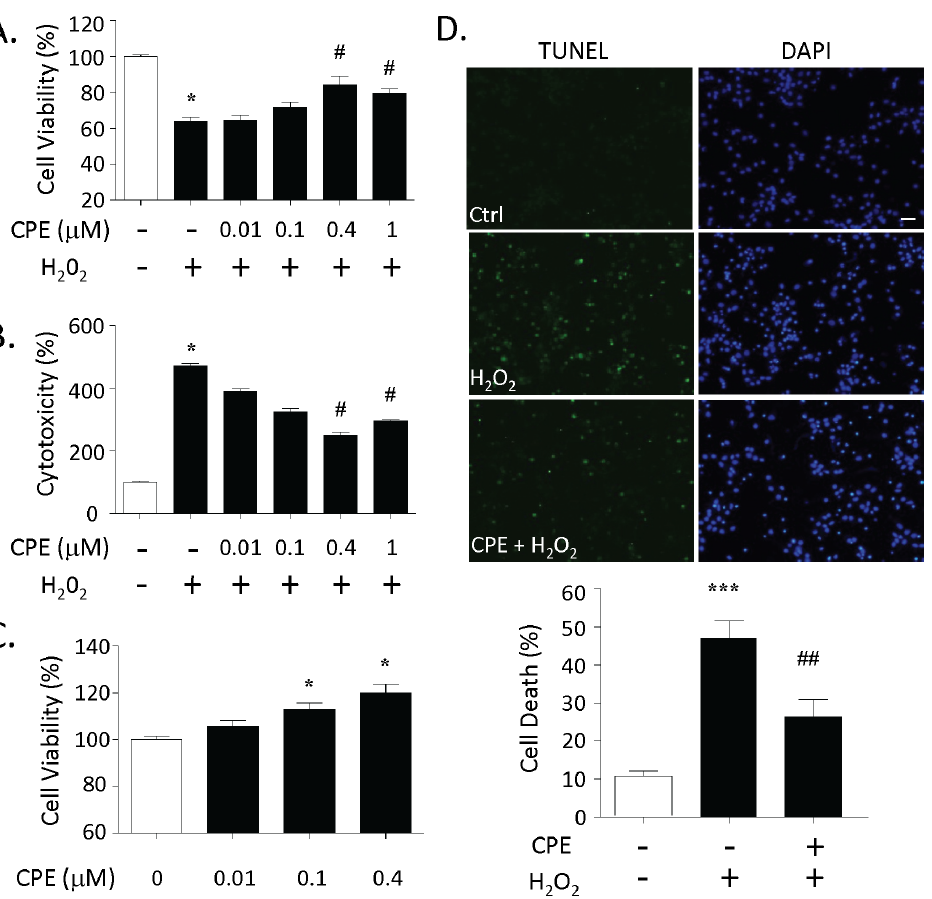
Figure 2. Purified recombinant CPE protein protects against H 2 O 2 -induced neurotoxicity in primary cultured rat hippocampal neurons. A) Bar graphs showing WST activity, indicative of cell viability, of hippocampal neurons treated with and without H 2 O 2 . Note the reduced cell viability after H 2 O 2 treatment that was significantly attenuated by the pretreatment of the neurons with 0.4 m M and 1 m M purified CPE. B) Bar graphs showing LDH activity, as in figure 1, in the culture media of hippocampal neurons treated with and without H 2 O 2 . Note that the H 2 O 2 -induced cytotoxicity was significantly attenuated by the pretreatment of the neurons with 0.4 m M and 1 m M purified CPE. C) Bar graphs showing WST activity of hippocampal neurons treated with purified CPE. Note that cell viability increased significantly by treatment with 0.4 m M and 1 m M CPE. D) Photomicrographs of hippocampal neurons with and without H 2 O 2 treatment stained by TUNEL (green) and DAPI (blue). Note that the number of dead cells (green) increased significantly after H 2 O 2 treatment (middle, left panel) and that pretreatment with 0.4 m M CPE protected the neurons (bottom, left panel). The bar graph represents the quantification of the dead cells as a % of the total number of cells determined by the DAPI staining. 500 cells were counted in each of 6 different dishes generated from embryos from 2 rats. A–C , one way ANOVA with Tukey post-hoc test, n=5, *p , 0.05 when compared to control cells; # p , 0.05 compared to H 2 O 2 treated only cells. D , Students t test, n=6, ***p , 0.001 compared to control cells; ## p , 0.01 compared to H 2 O 2 treated only cells. Bar=100 m